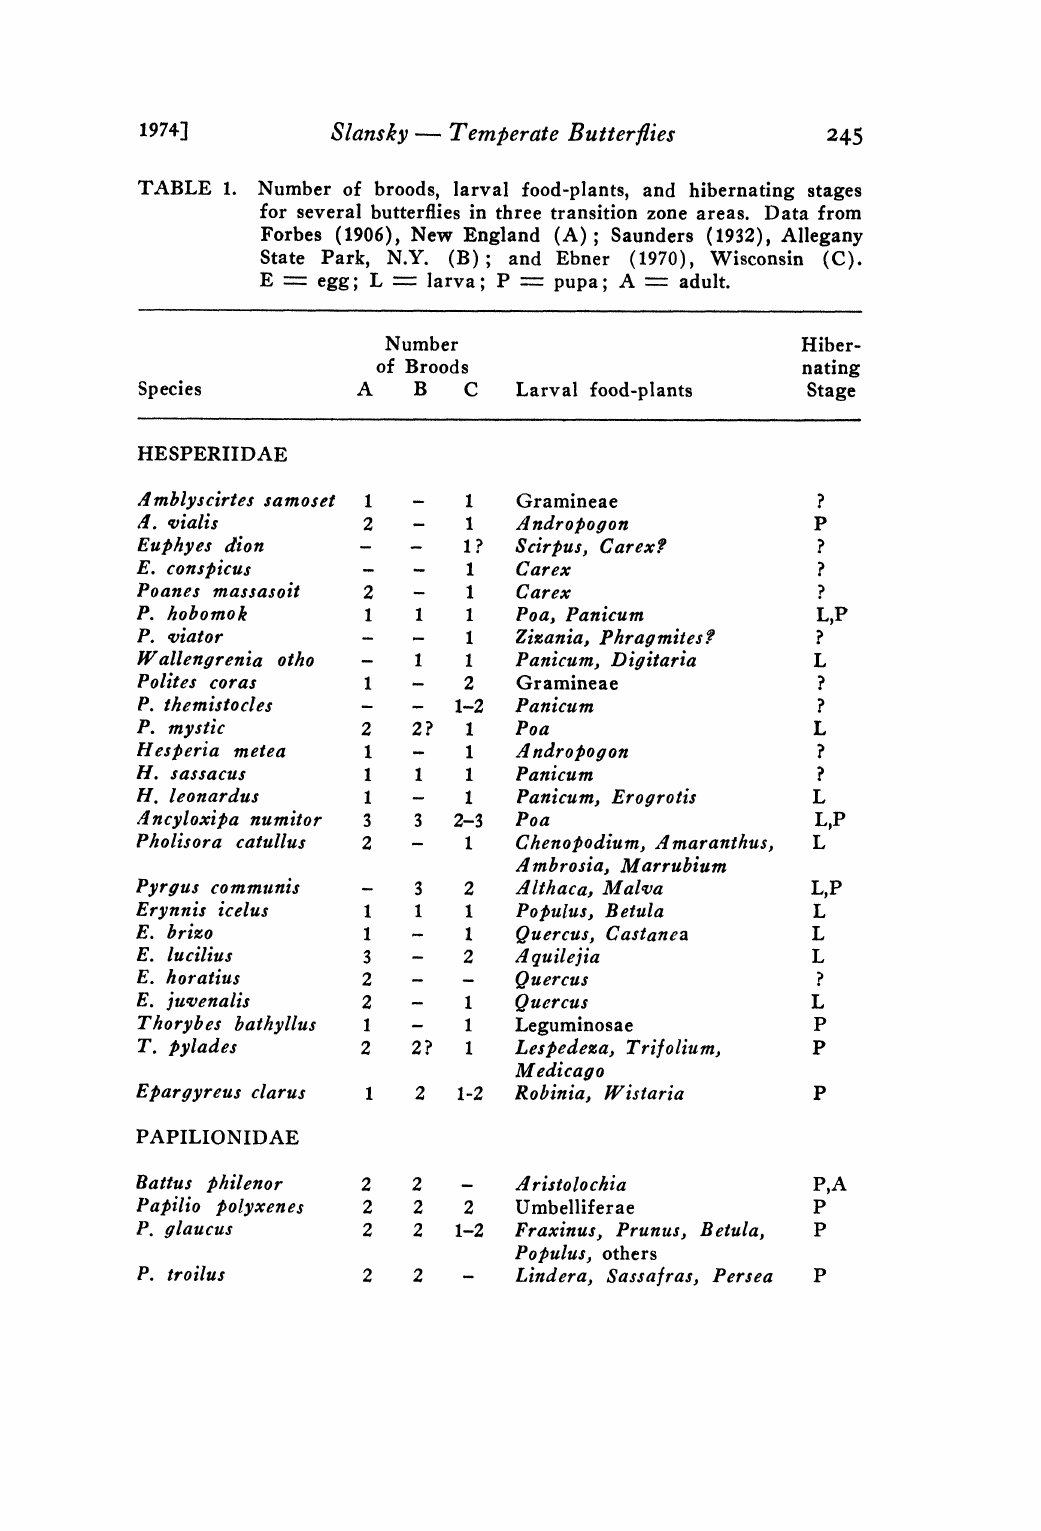
8lansky--- Temlerate Butterflies 245 Number of broods, larval food-plants, and hibernating stages for several butterflies in three transition zone areas. Data from Forbes (1906), New England (A); Saunders (1932), Allegany State Park, N.Y. (B); and Ebner (1970), Wisconsin (C). E : egg; L "--" larva; P : pupa; A :